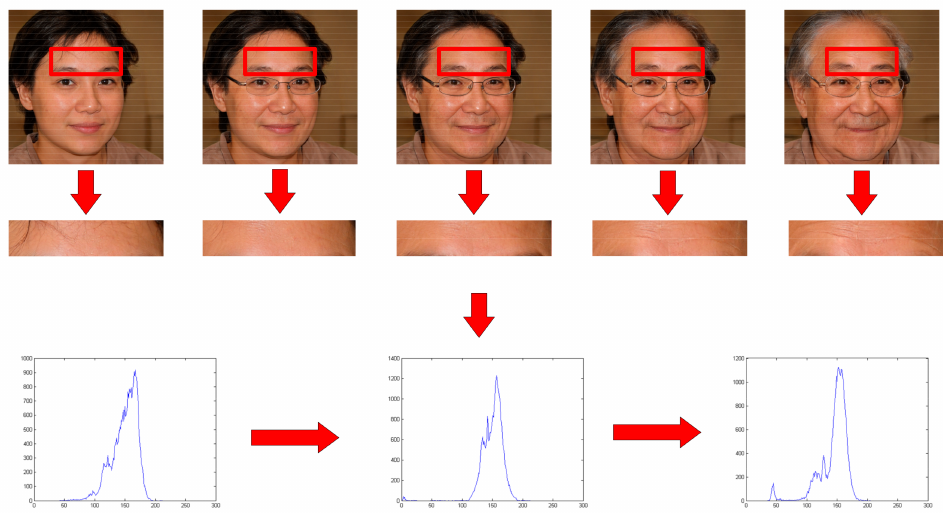
Figure 2. The appearance of the same person at different ages, and the forehead of each period, the bottom is the histogram of the forehead.